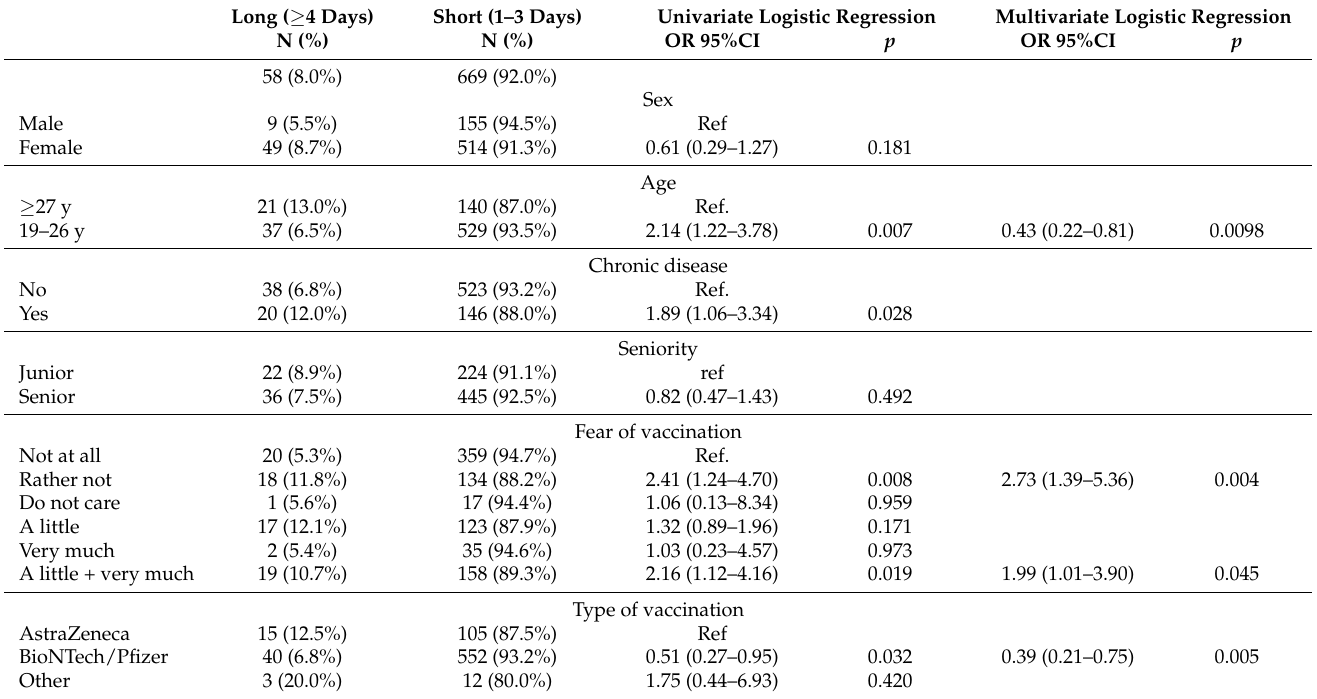
Table 8. Associations between sex, age, chronic disease, seniority, fear of vaccination, type of vaccination, and length of adverse reactions after vaccination. Long ( ≥ 4